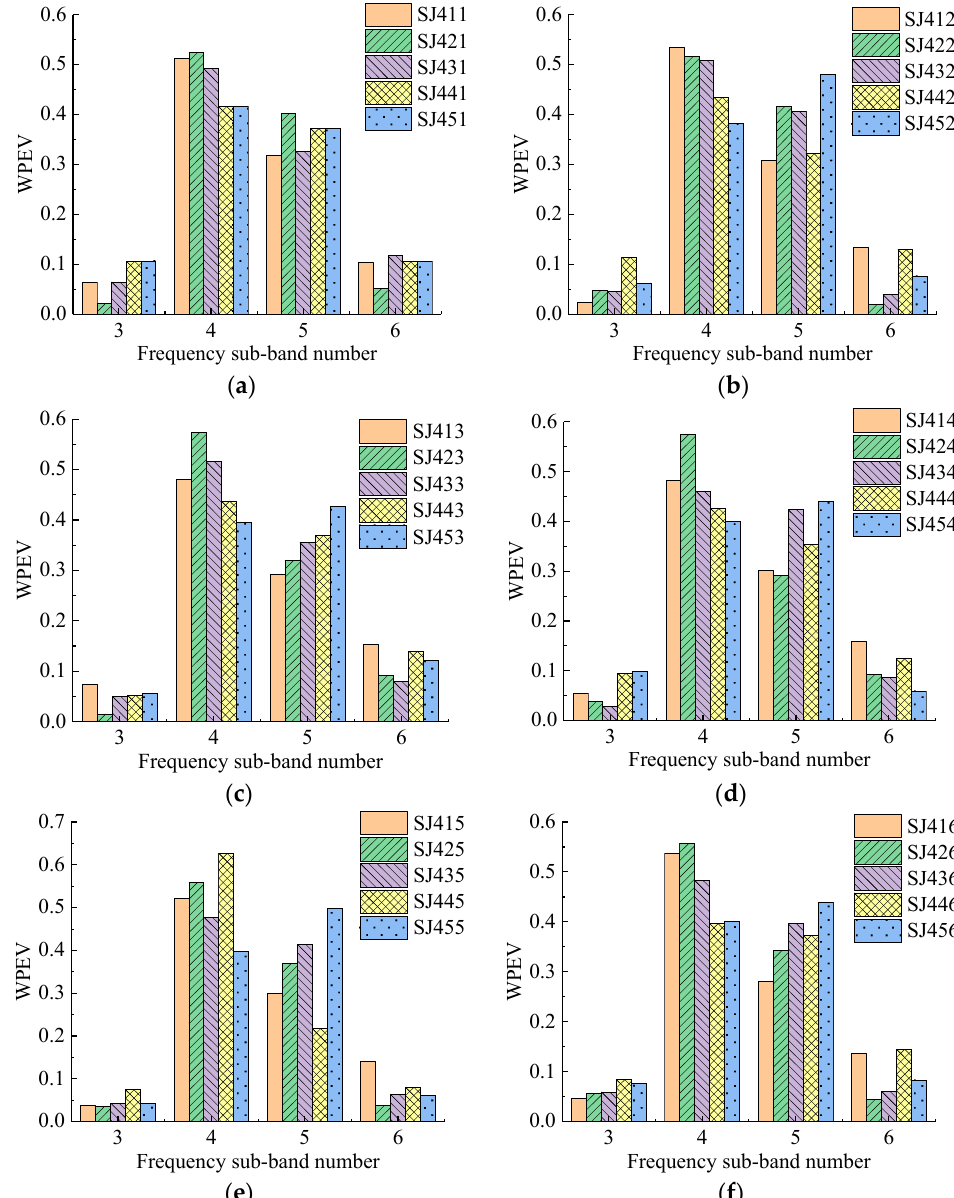
Figure 8. The WPEVs of different detecting points of the SJ3 group. ( a ) Detecting point 1, ( b ) Detecting point 2, ( c ) Detecting point 3, ( d ) Detecting point 4, ( e ) Detecting point 5, ( f ) Detecting point 6.